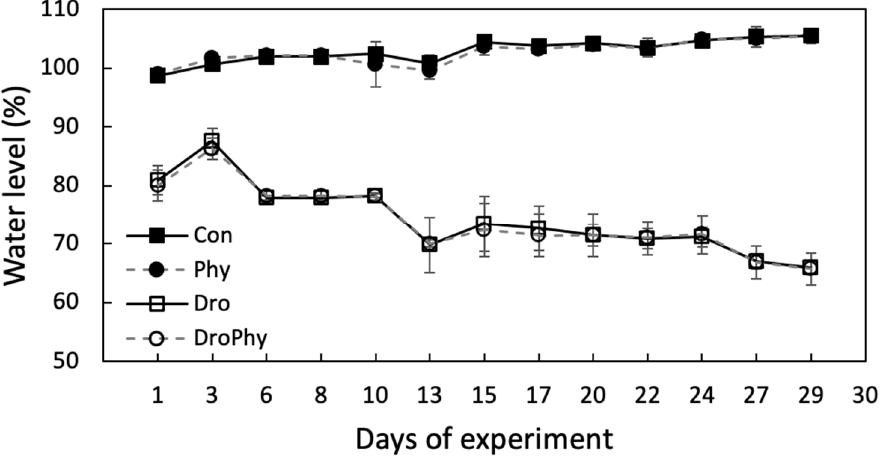
Figure 1. Relative pot weight as a percentage of the initial pot weight of E. obliqua seedlings subjected to Control (Con), Drought (Dro), Phytophthora (Phy), and Drought- Phytophthora (DroPhy) treatments. Bars indicate ± standard errors of the mean values. Where no error bars are visible, the values are smaller than the size of the symbol.